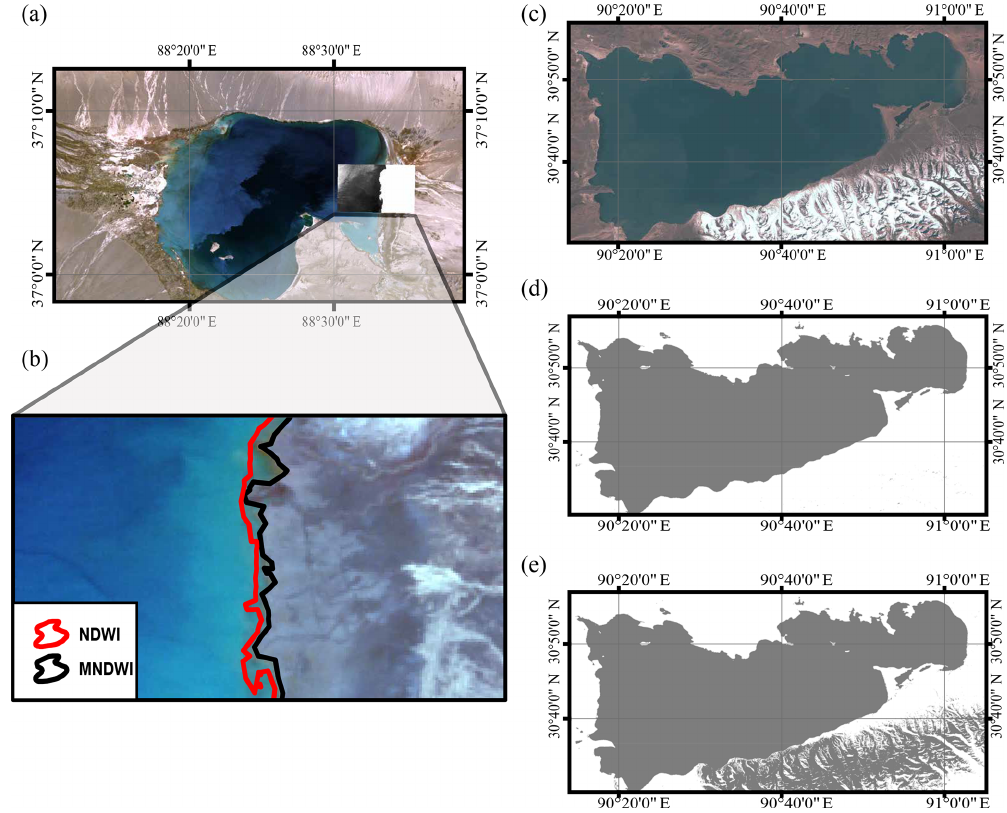
Figure 5. (a) A Landsat 7 ETM + image of Lake Aqqikkol acquired in summer in 2001; (b) water area extractions using the modified normalized difference water index (MNDWI) and the normalized difference water index (NDWI), showing that the MNDWI performs better in detecting shallow water; (c) a Landsat 8 OLI image of Nam Co acquired in winter in 2015; (d) water area extraction using the NDWI, showing good performance in distinguishing water from snow; and (e) water area extraction using the MNDWI, showing some confusion of water and